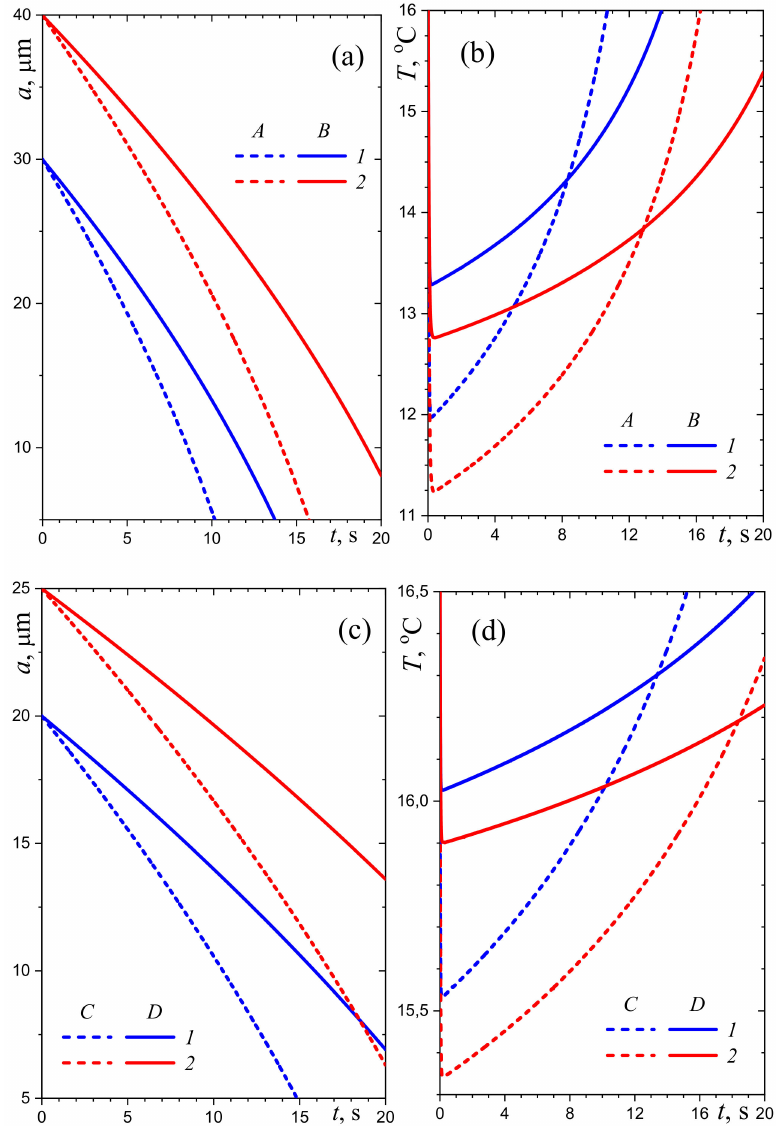
Figure 3. Time-dependency of the droplet radius and temperature ( a , b ) at low RH of air ( A —20%, B —40%; 1 — a 0 = 30 µ m, 2 —40 µ m) and ( c , d ) at high RH of air ( C —70%, D —80%; 1 — a 0 = 20 µ m, 2 —25 µ m); T air = 17 ◦